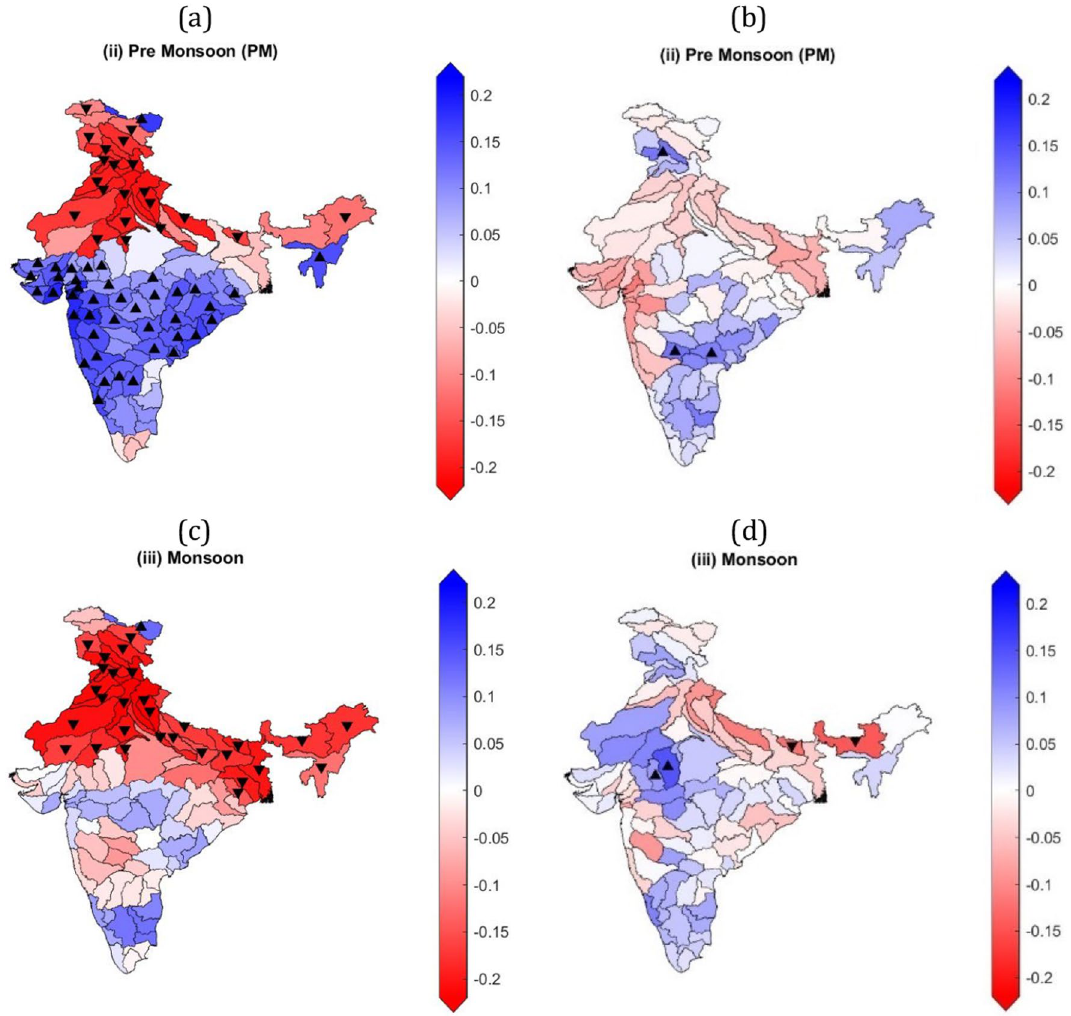
Figure 5. Seasonal CCDI/GRACE-DSI trends using the Mann Kendall trend test and Theil-Sen’s slope estimator over major Indian river basins from the Monsoon season. ( a ) GRACE-DSI trends for pre-monsoon season, ( b ) CCDI trends for pre-monsoon season, ( c ) GRACE-DSI trends for monsoon season, and ( d ) CCDI trends for monsoon season, respectively. Colormap over the basin represents the slope obtained from TSA, △ represents a significant increasing trend, and ▽ indicates a significant decreasing trend based on the Mann– Kendall